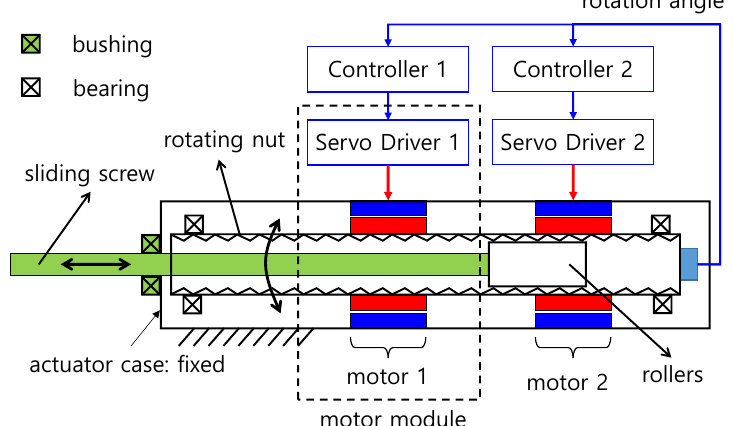
Figure 4. Linear actuator based on dual-type motors.